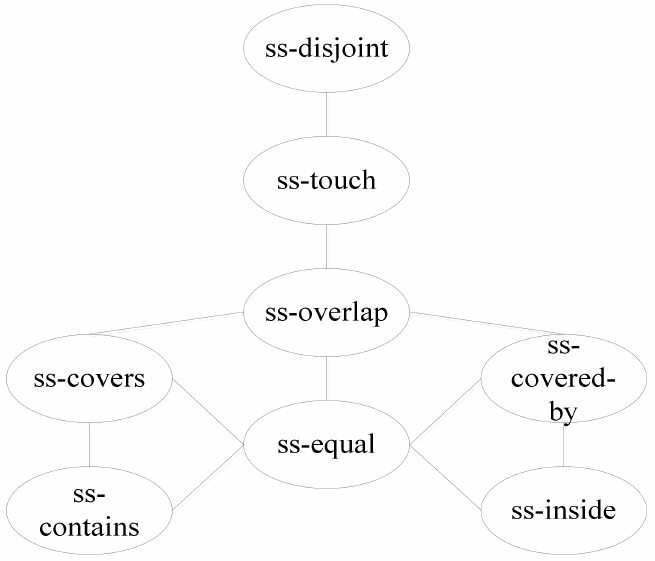
Figure 14. Conceptual neighborhood diagram of topological relations between two polygons. Table 7. Topological relation distances between a line segment and a